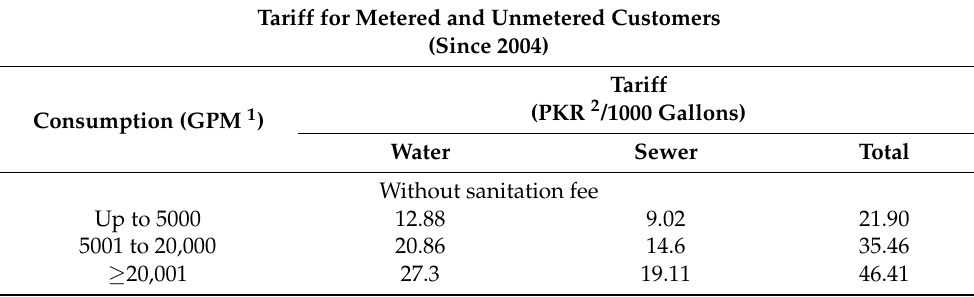
Table 3. Water and sewer tariff for metered and unmetered